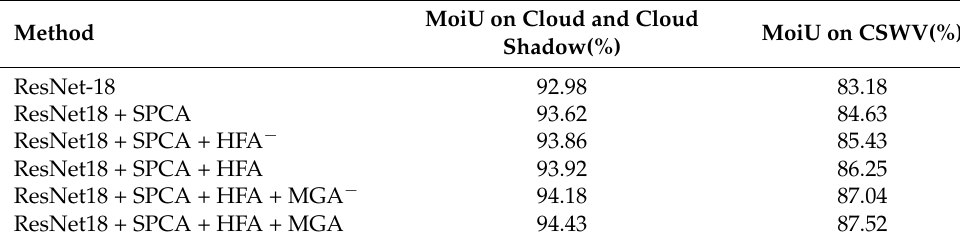
Table 2. Ablation